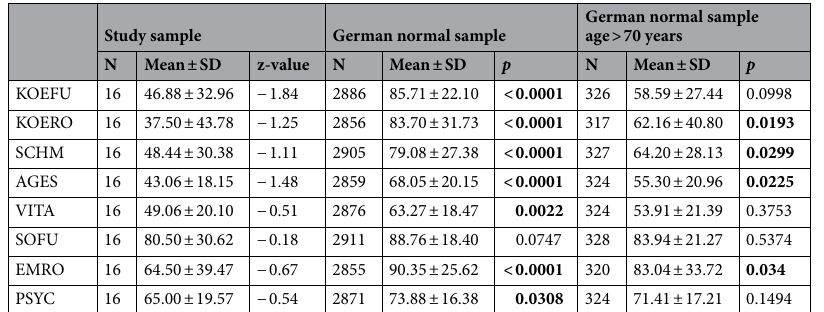
Table 2. SF-36 questionnaire. Significant values are in [bold]. KOEFU physical function, KOERO physical role, SCHM bodily pain, AGES general health, VITA vitality, SOFU social function, EMRO emotional role, PSYC mental